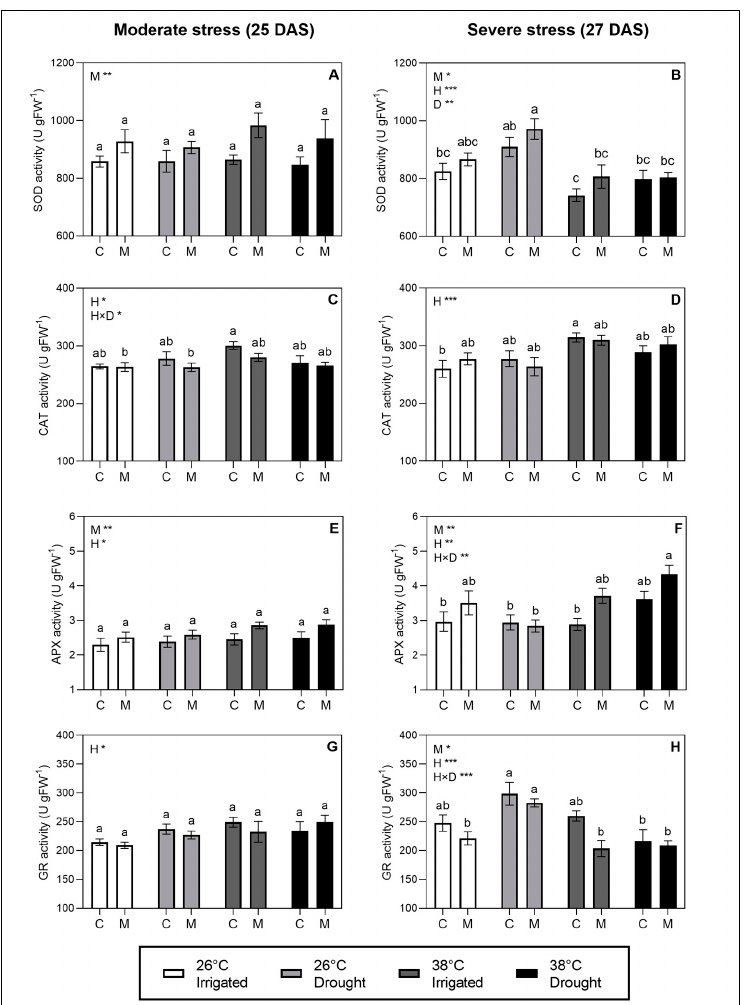
Figure 4. Enzymes assay on fresh leaf material for SOD ( A , B ), CAT ( C , D ), APX ( E , F ) and GR ( G , H ) at moderate stress (drought-stressed at SRWC ~50% and heat stress for 1 day) and severe stress (drought-stressed at SRWC ~20% and heat stress for 3 days). Values are mean ± SE. The effects of the three factors studied—heat stress (H), drought stress (D), melatonin treatment (M)—and their interaction are indicated in the left, upper corners of graphs. Significance levels are indicated by ***, p < 0.001; **, p < 0.01; *, p < 0.05, whereas factors with no significant effect ( p > 0.05) are not listed. Lower-case letters on bars indicate differences between groups within each stress level significant at p < 0.05 in the post hoc multiple